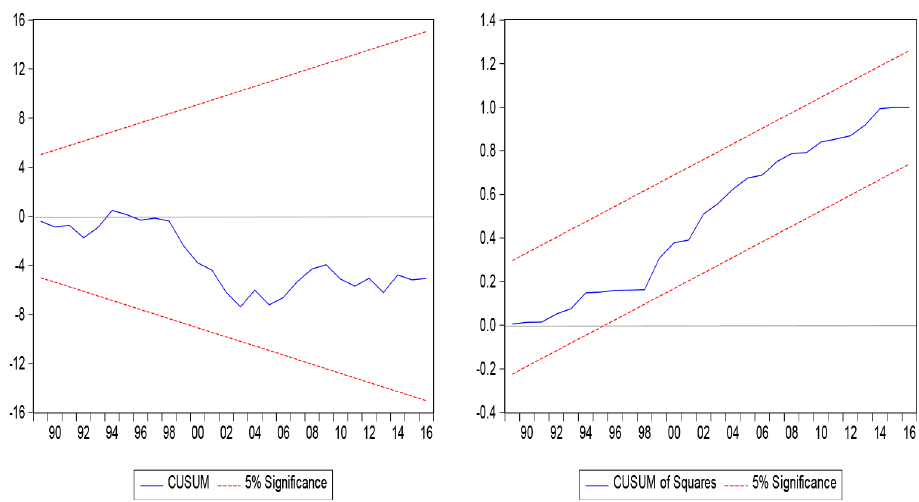
Fig. 5. Cusum and Cusumsq plots for Model 3. Source: own